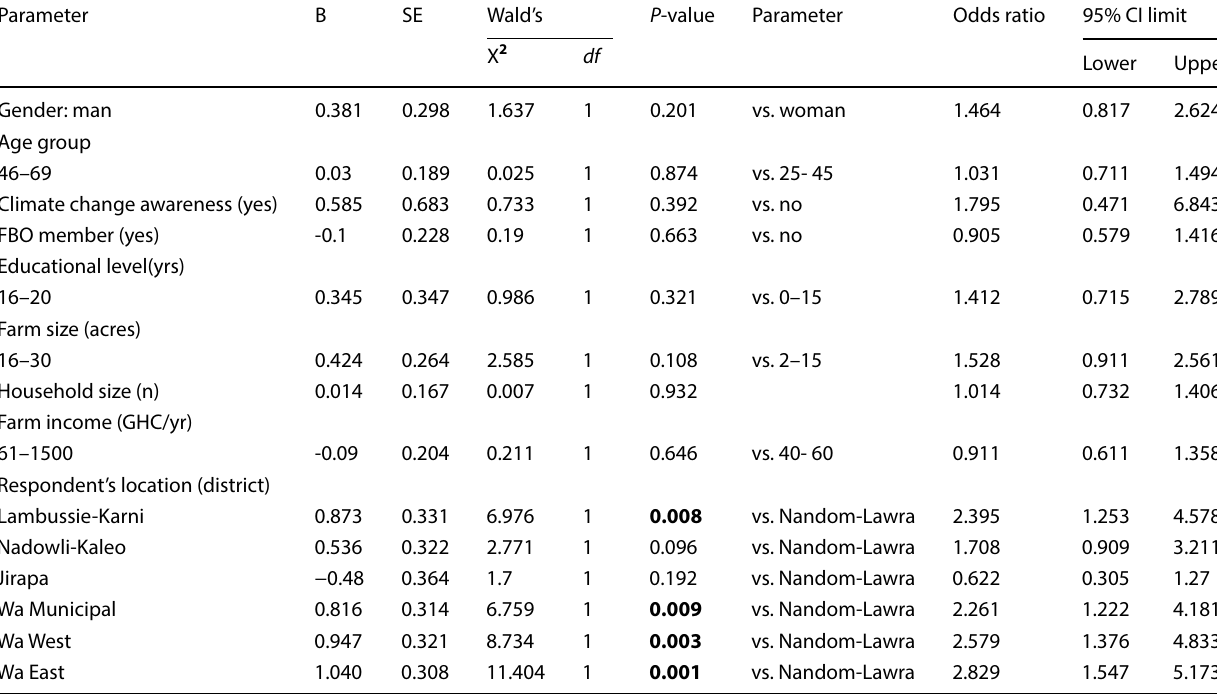
The significant values ( p values) have been provided for these bold values in the